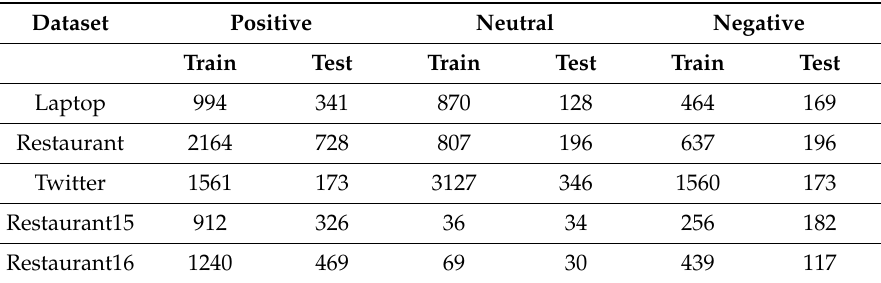
Table 1. The details of the datasets.